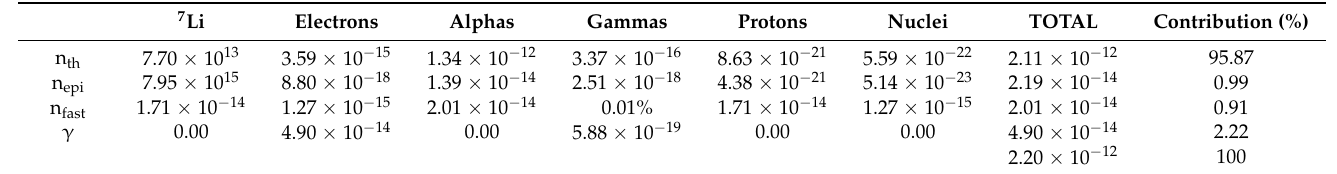
Table 4. Contribution of the different primaries to the overall deposited energy in the cell layer (Gy/n · cm 2 ).